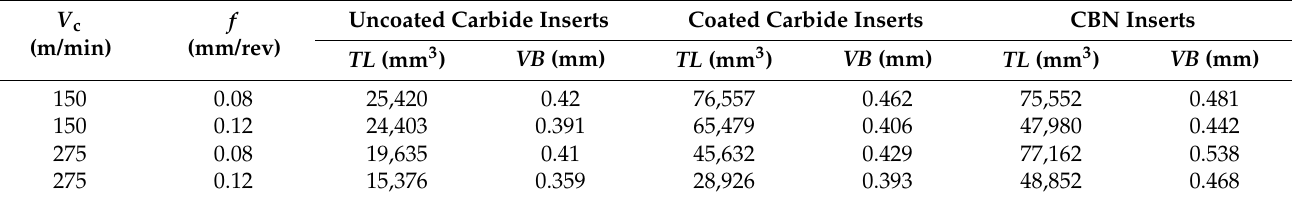
Table 3. TL and VB at the completion of tool